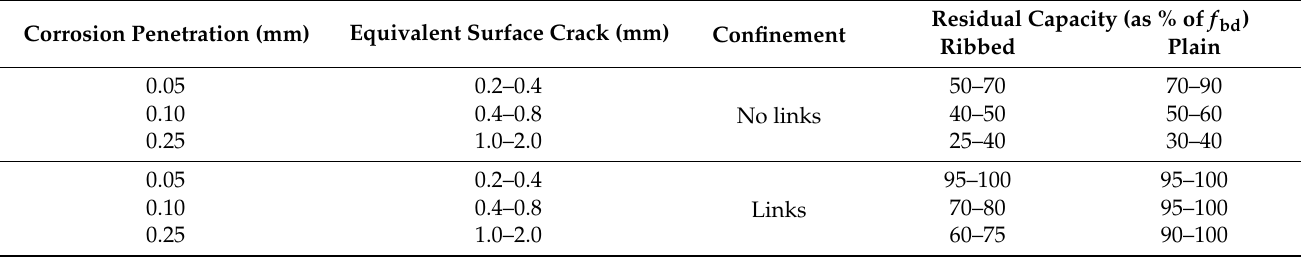
Table 1. Magnitude of reduction in residual bond strength for corroded reinforcement (Fib Model Code 2010). Corrosion Penetration